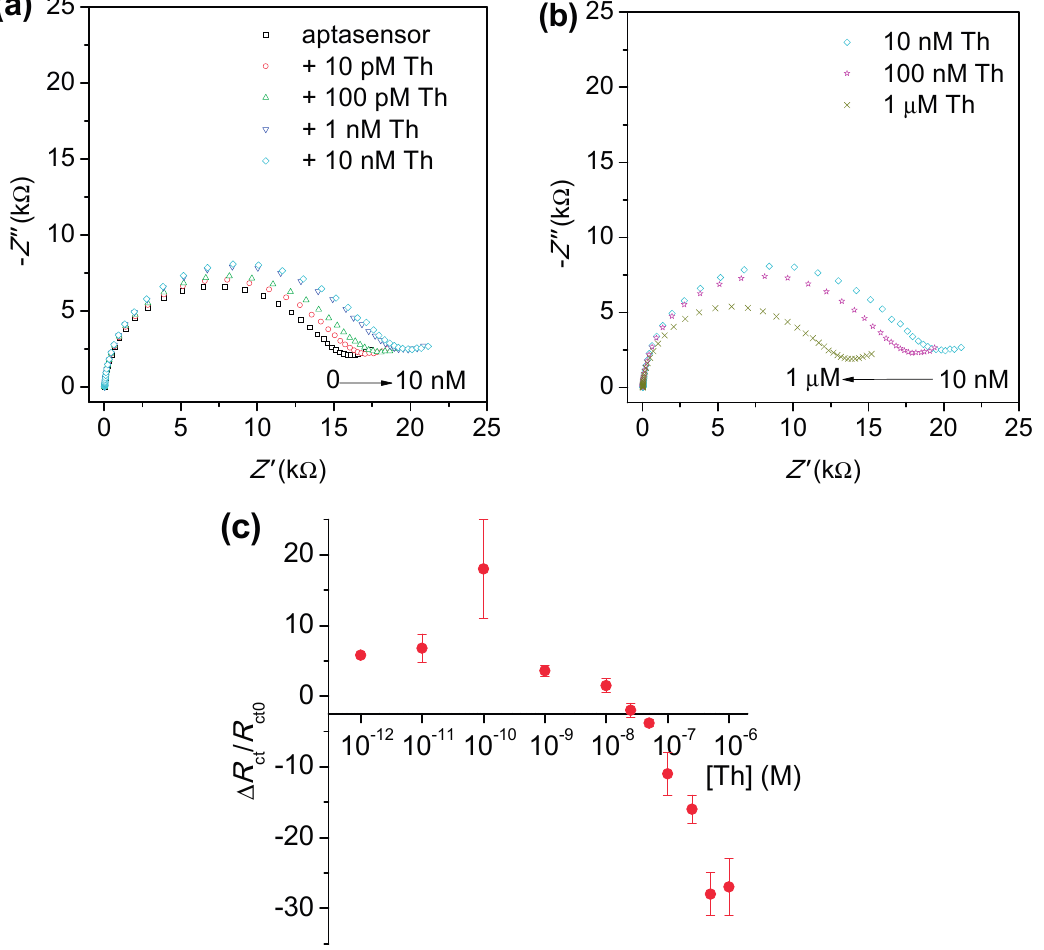
Figure 4. Nyquist plots obtained after successive incubation of biosensors with thrombin in concentrations range ( a ) from 10 pM to 10 nM and ( b ) from 10 nM to 1 µM. ( c ) Calibration curve obtained based on charge transfer resistance ( R ct ) value variation after incubation of freshly prepared biosensors with various thrombin (Th) concentrations. The error